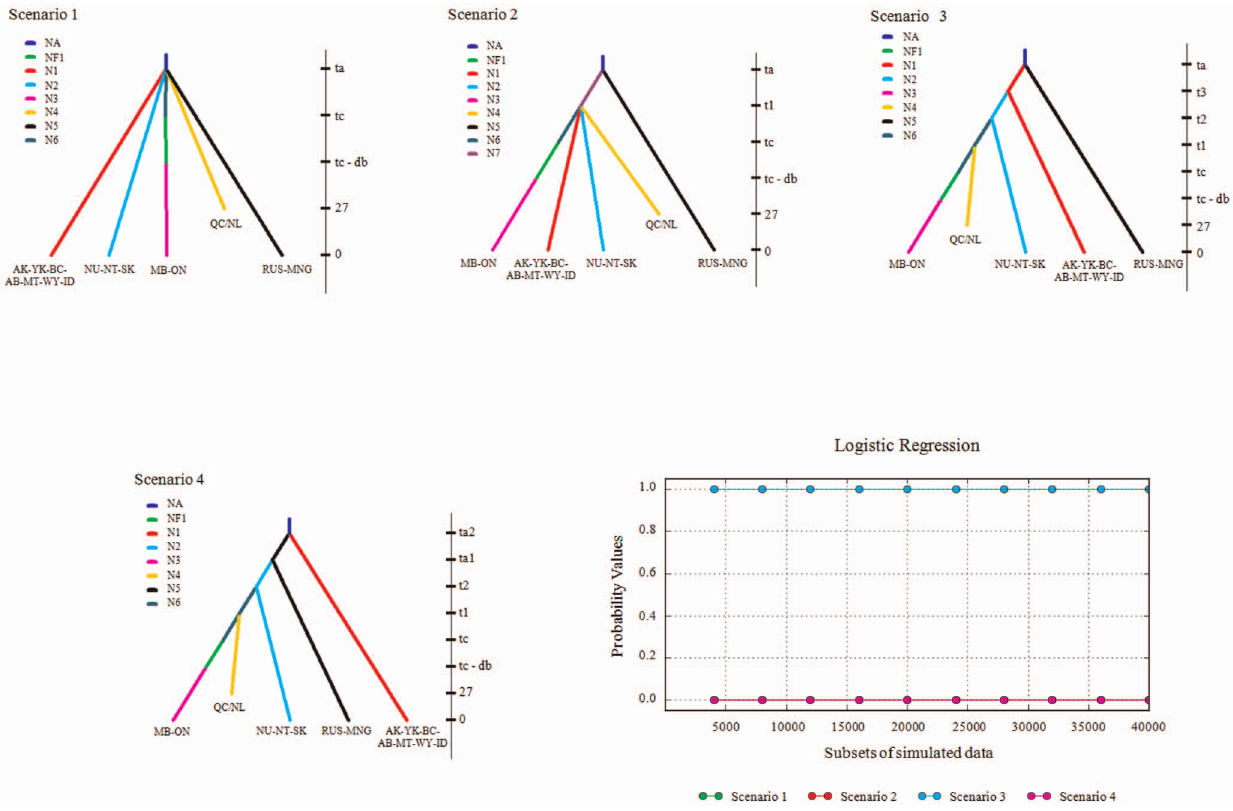
Figure 2. Scenarios used in DIYABC and logistic regression. Graphic representation of the four scenarios used in DIYABC and logistic regression of posterior probabilities with a recent bottleneck (20th century) for MB-ON. Please note that time is not to scale.